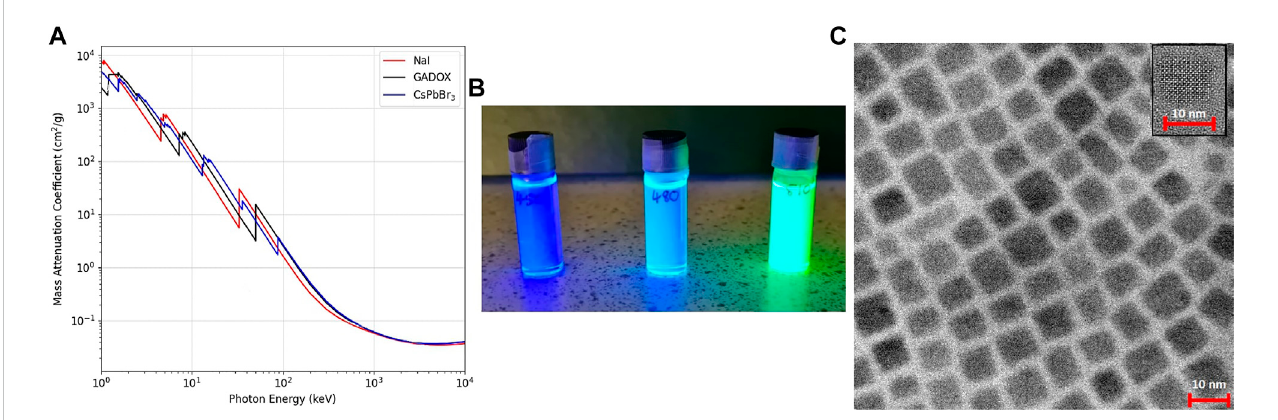
FIGURE 1 (A) Mass attenuation coef fi cient plots for CsPbBr